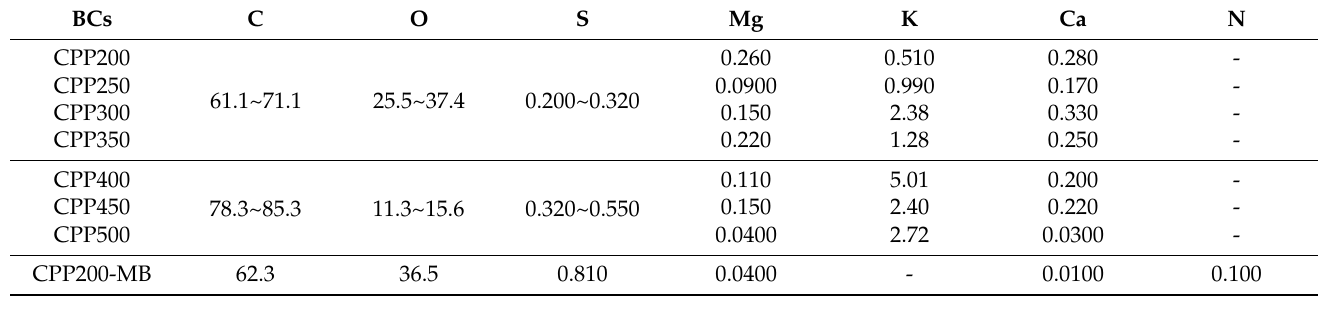
Table 1. Elemental compositions (at.%) of BC samples prepared by vacuum pyrolysis and CPP200 post-adsorption of MB.